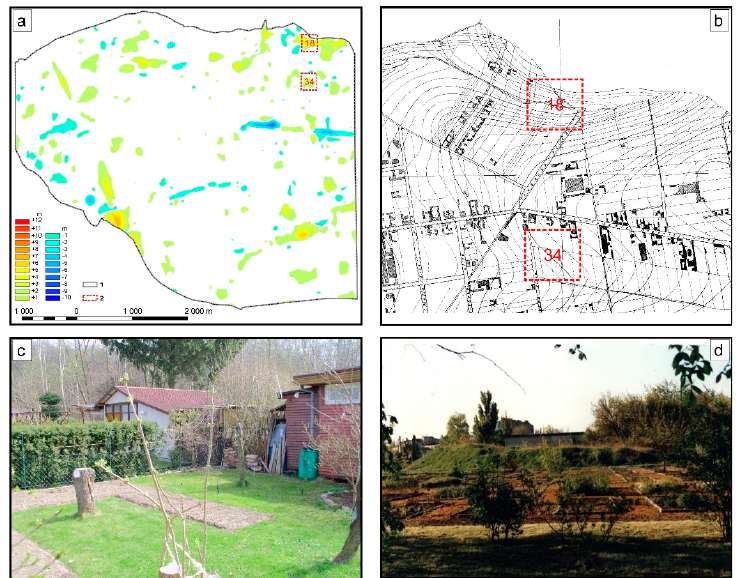
Figure 20. Changes in the relief of Ł ód ź associated with mineral extraction and reclamation of exca- vations (photo Kuhn 1994). ( a ) location map (1—boundaries of Jasi ń ski’s Map; 2—areas of analysis); ( b ) topographic situation of the analysed area on Jasi ń ski’s Map; ( c ) site of former raw material extraction in Telefoniczna Street; ( d ) the site of former shelters in Kopci ń skiego